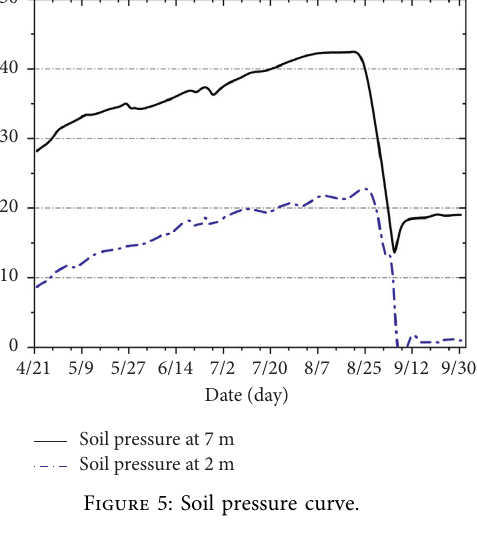
Figure 5: Soil pressure curve.